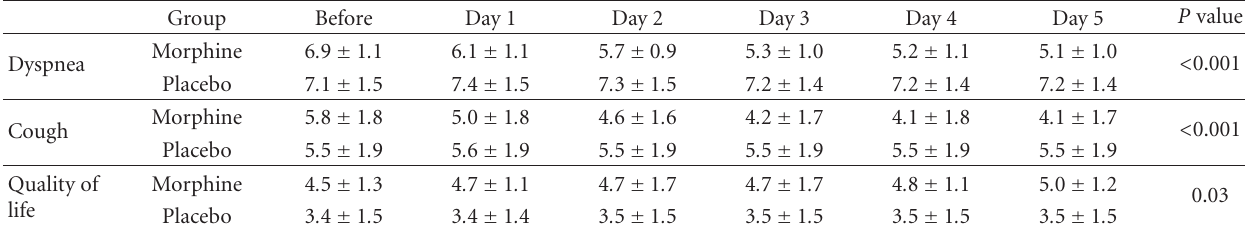
Table 2: Mean of di ff erences in respiratory rate, hear rate, night time awaking for dyspnea, and cough in two groups. Morphine Placebo P value Respiratory rate 1 . 5 ± 1 . 1 0 . 1 ± 0 . 3 < 0.001 Heart rate 1 . 7 ± 1 . 6 0 . 45 ± 0 . 6 0.004 Night time awaking for dyspnea 1 . 0 ± 0 . 6 0 . 5 ± 0 .